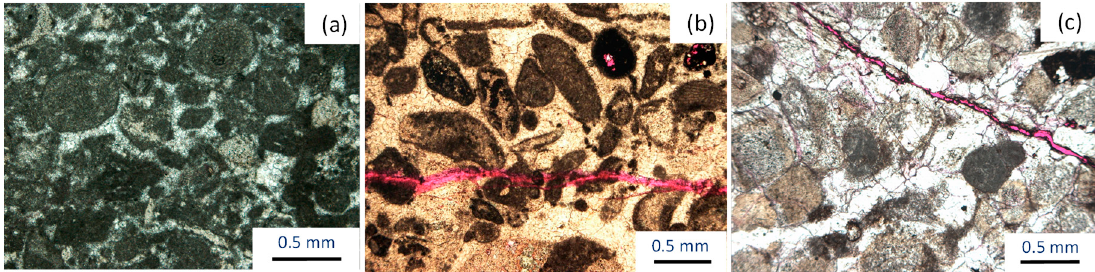
Figure 4. Photomicrographs showing compaction observed in the thin sections (pink-dye resin impregnated to better illustrate sample porosity). ( a ) Grainstone showing line contacts in country rocks, H6-1, 6667.93 m; ( b ) floating grains in grainstone showing weak compaction in a fault damage zone, H7-3, 6644.47 m; ( c ) strong compaction and recrystallization in a fault damage zone, H803, 6578 m.